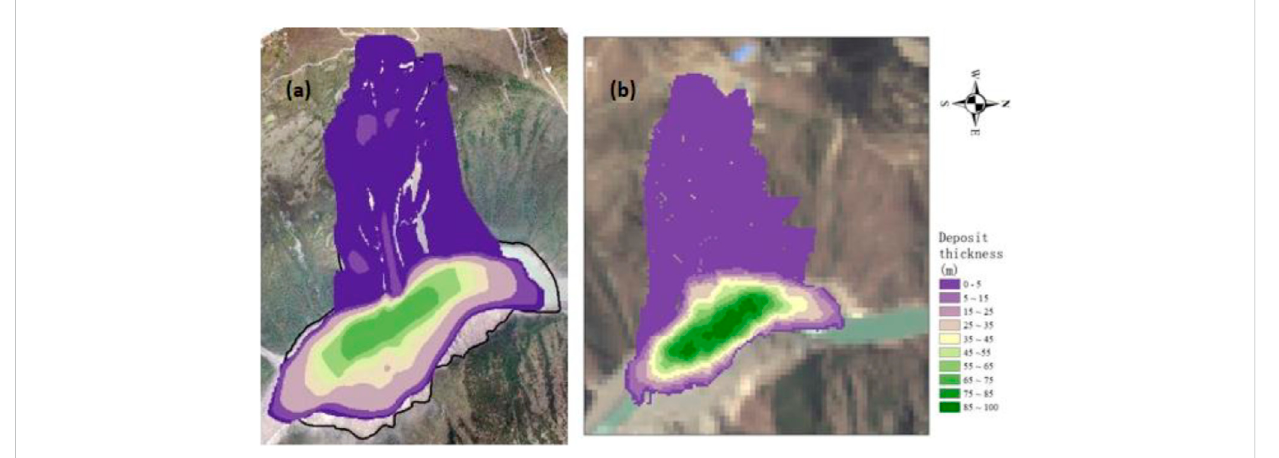
Deposit thickness of the fi rst Baige landslide: (A) actual result and (B) numerical simulation.